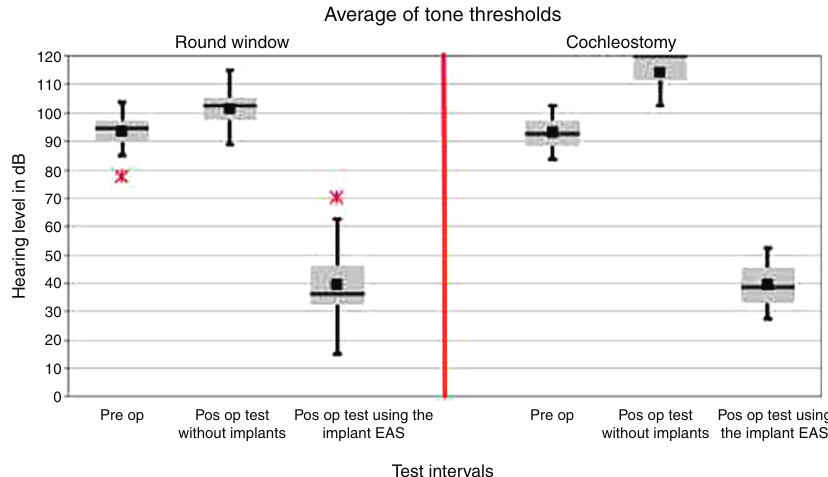
Test intervals Figure 8 Average pure tone hearing threshold (500 Hz, 1 kHz, 2 kHz, 3 kHz): the graph shows the comparison between preoperative versus postoperative tests, with no use of the cochlear implant (hearing level in dB). The analysis was stratified by inner ear approach (Round window --- n = 16; Cochleostomy --- n = 3). Mean values are shown as vertical black lines, medians as horizontal lines. Red asterisk represents